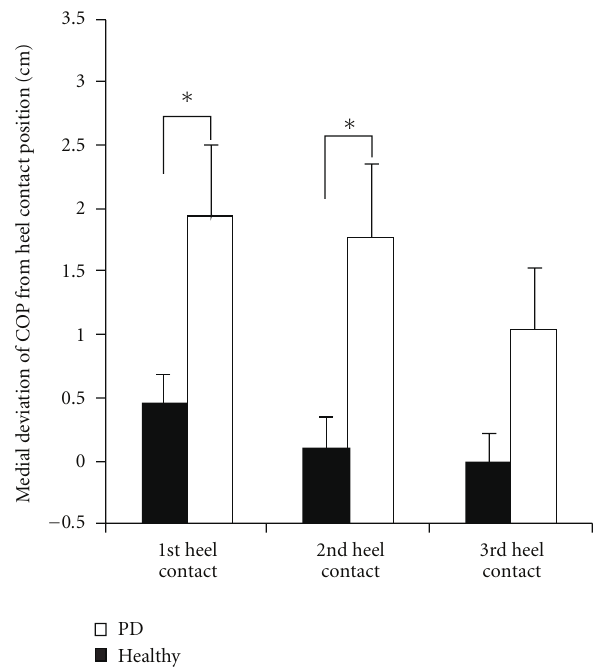
Figure 5: Medial deviation of the COP from the heel contact posi- tion. Data columns indicate the mean, and error bars indicate stan- dard errors of the mean. Asterisks indicate a significant di ff erence between the groups ( P < 0 .